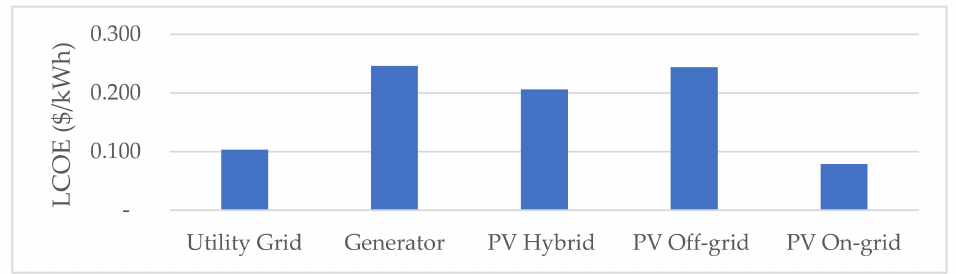
Figure 10. LCOE Results of Energy